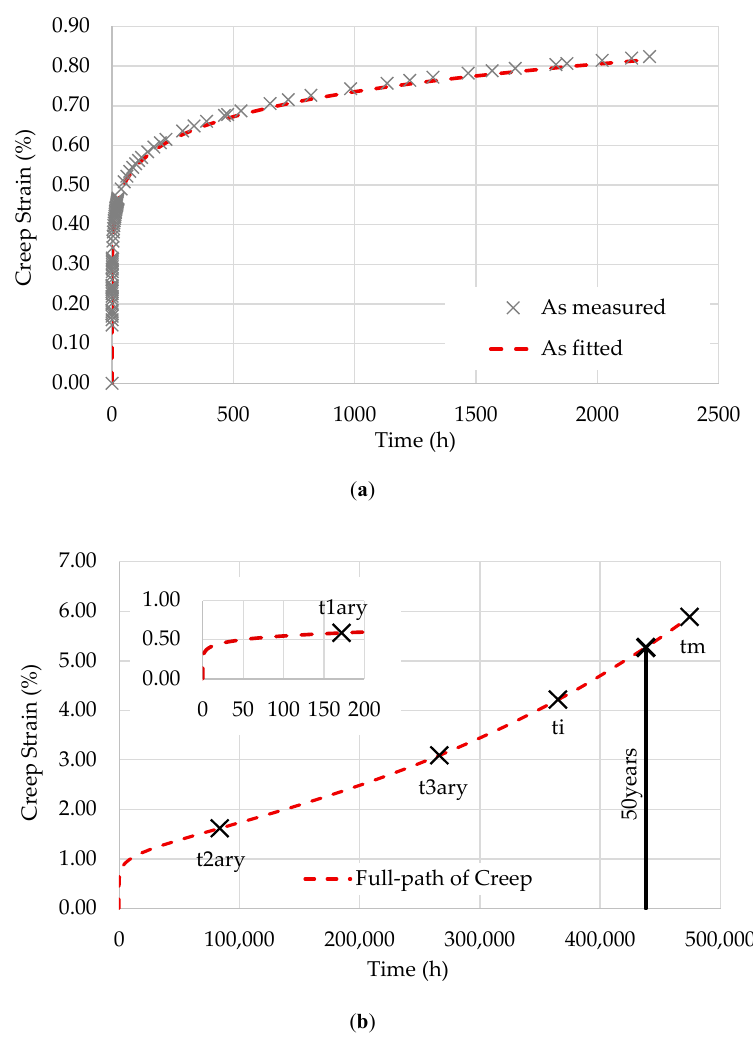
Figure 3 T28-S25: ( a ) data fitting; ( b ) full path of creep and transition points. Figure 3. T28-S25: ( a ) data fitting; ( b ) full path of creep and transition points. Polymers 2020 , 12 , x FOR PEER REVIEW